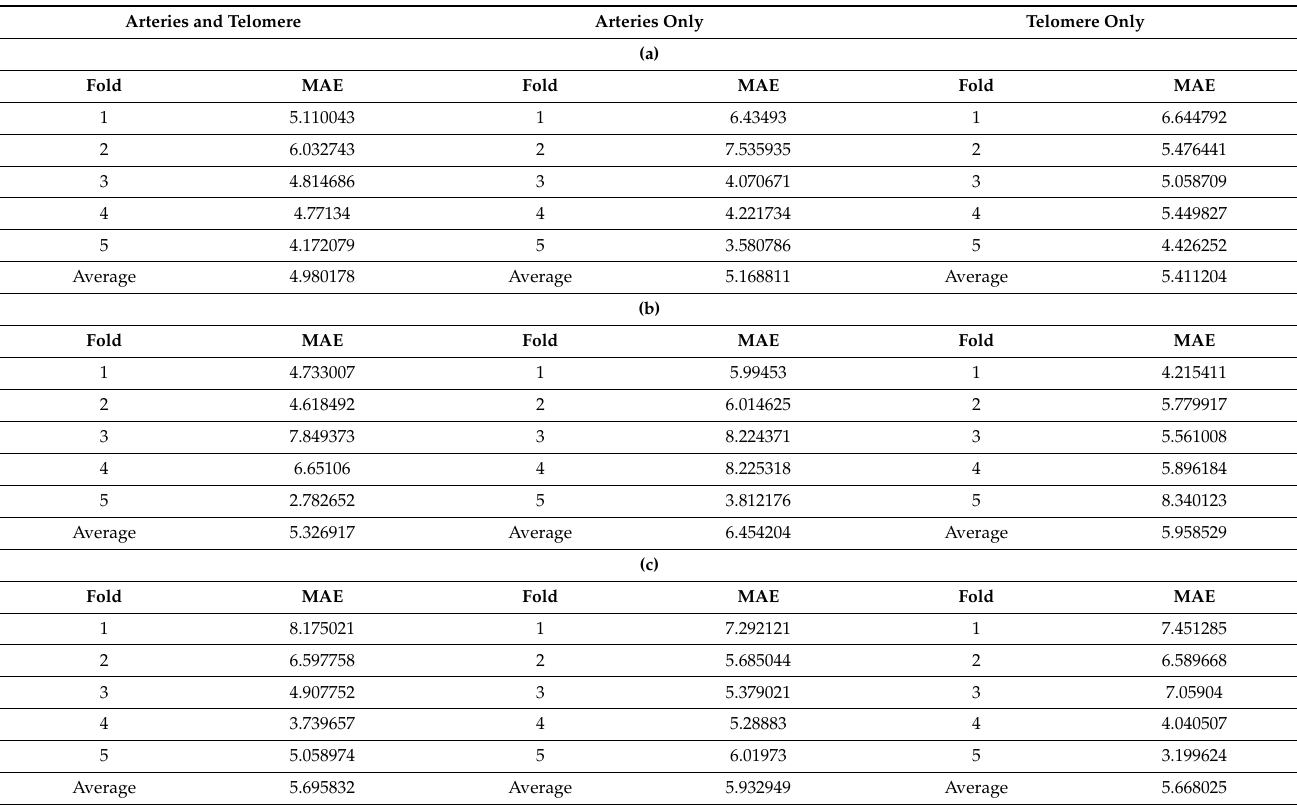
Table 6. ( a ) Mean absolute errors for diastolic BP predictions (Age group 1). ( b ) Mean absolute errors for diastolic BP predictions (Age group 2). ( c ) Mean absolute errors for diastolic BP predictions (age group